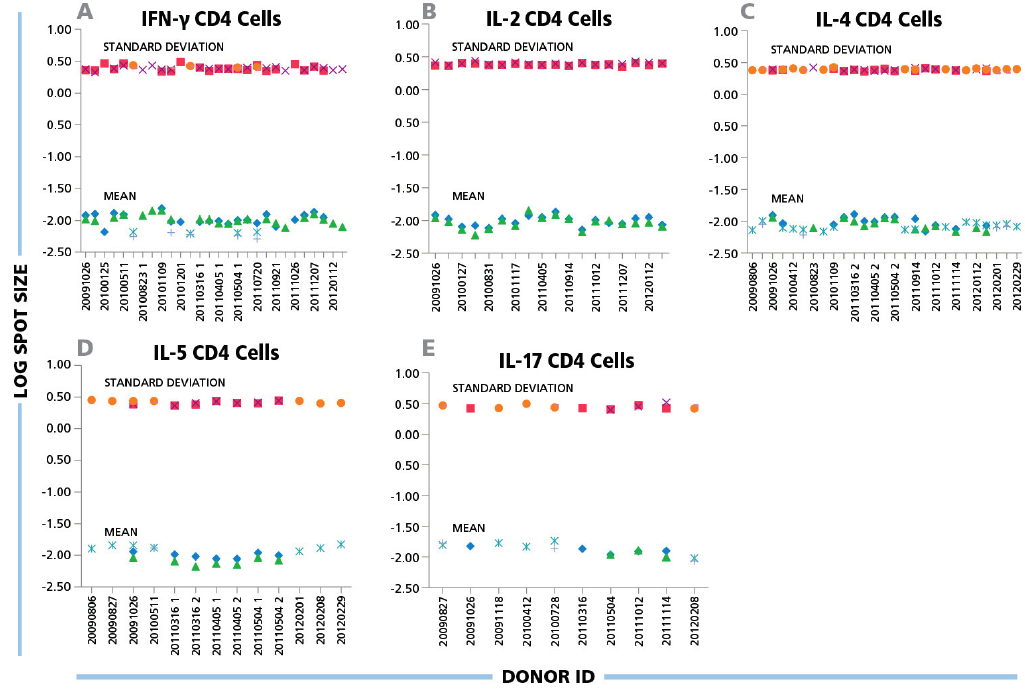
Figure 4. ( A ) IFN- γ , ( B ) IL-2, ( C ) IL-4, ( D ) IL-5, and ( E ) IL-17 ELISPOTs produced by CD4 cells show a maximal three-fold size variation between donors and antigens. Inactivated EBV or CMV virions (indicated by the different symbols) were used to induce CD4 cells of different donors to produce the cytokines specified in the panels. The mean spot size (mm 2 ) and SD for each positive response (y-axis) are plotted in the logarithmic scale vs. the individual donors’ ID specified on the x-axis. For each data point 1000 spots were